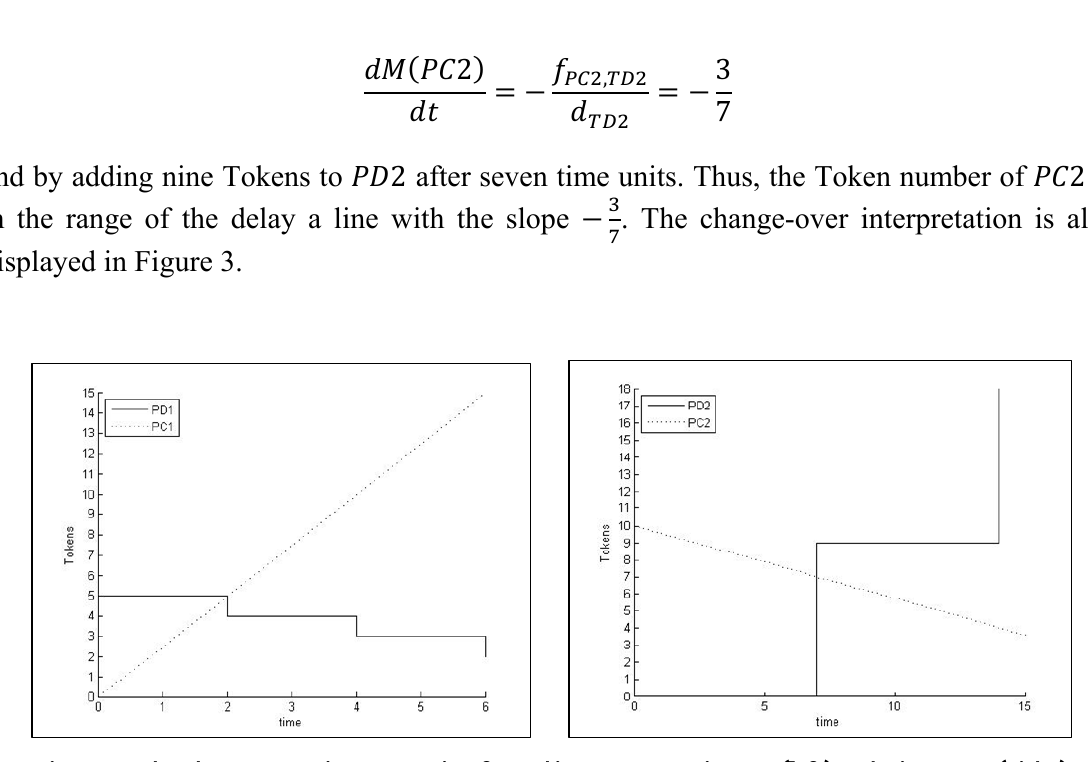
Figure 3: The change-over interpretation from discrete to continuous (left) and vice versa (right) of the examples in Figure